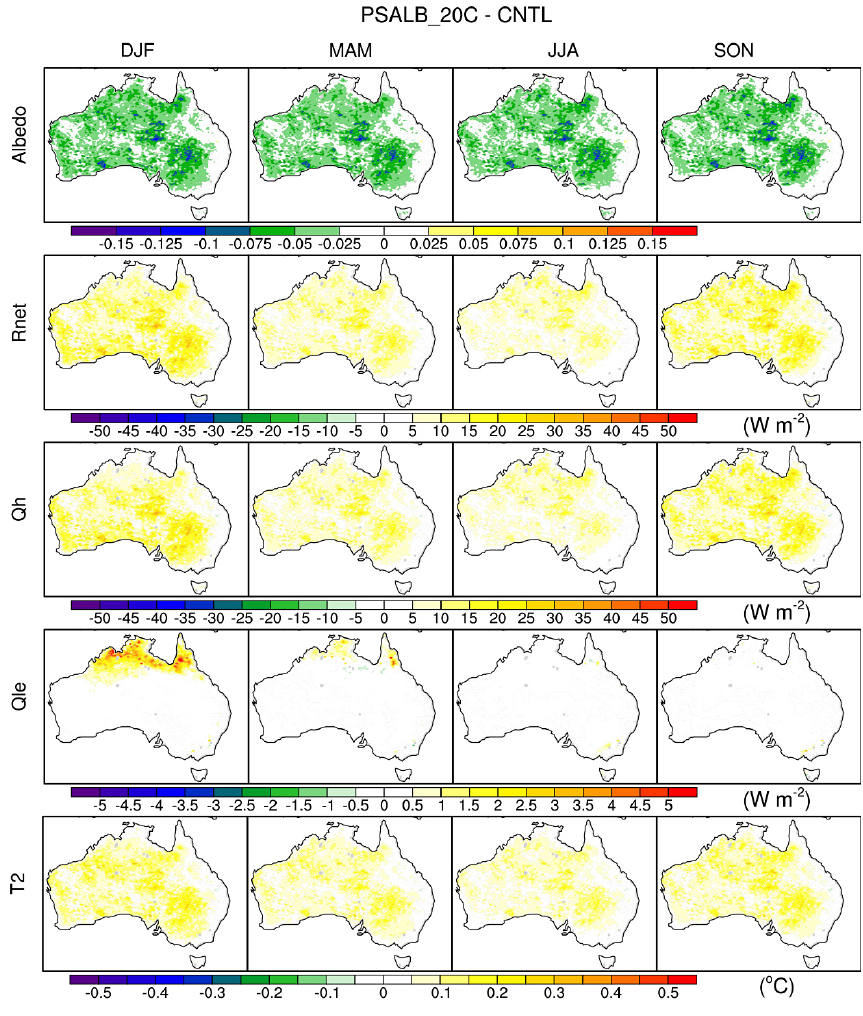
Figure 15. Same as in Fig. 13 but for the PSALB_20C